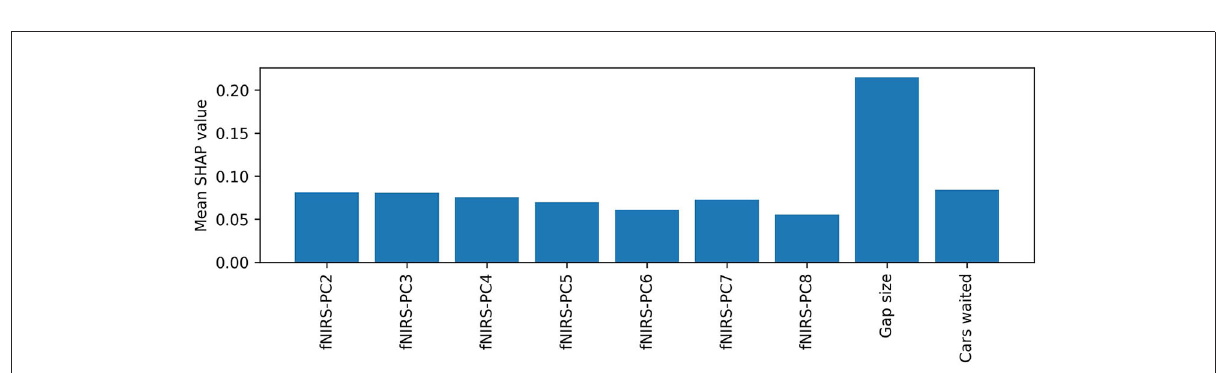
FIGURE7 Mean absolute SHAP values for each feature of the combined model. The features are sorted by descending SHAP values.